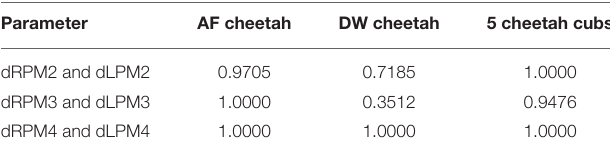
TABLE 4 | Comparisons of the distributions of probabilities for FP across dRPM2 and dLPM2, across dRPM3 and dLPM3, and across dRPM4 and dLPM4